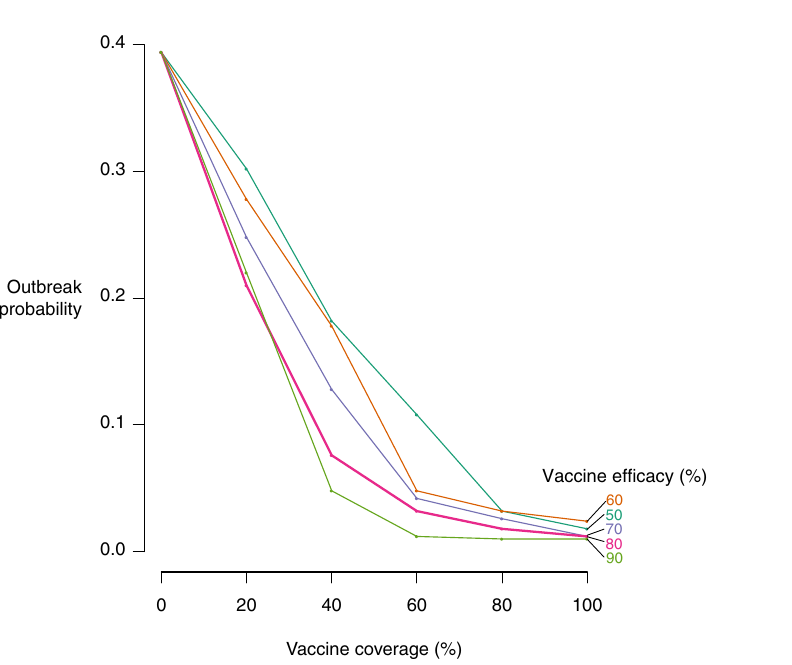
Figure 7. Effect of varying vaccine coverage and efficacy on the probability of an outbreak (the proportion of simulations that resulted in widespread influenza infections across